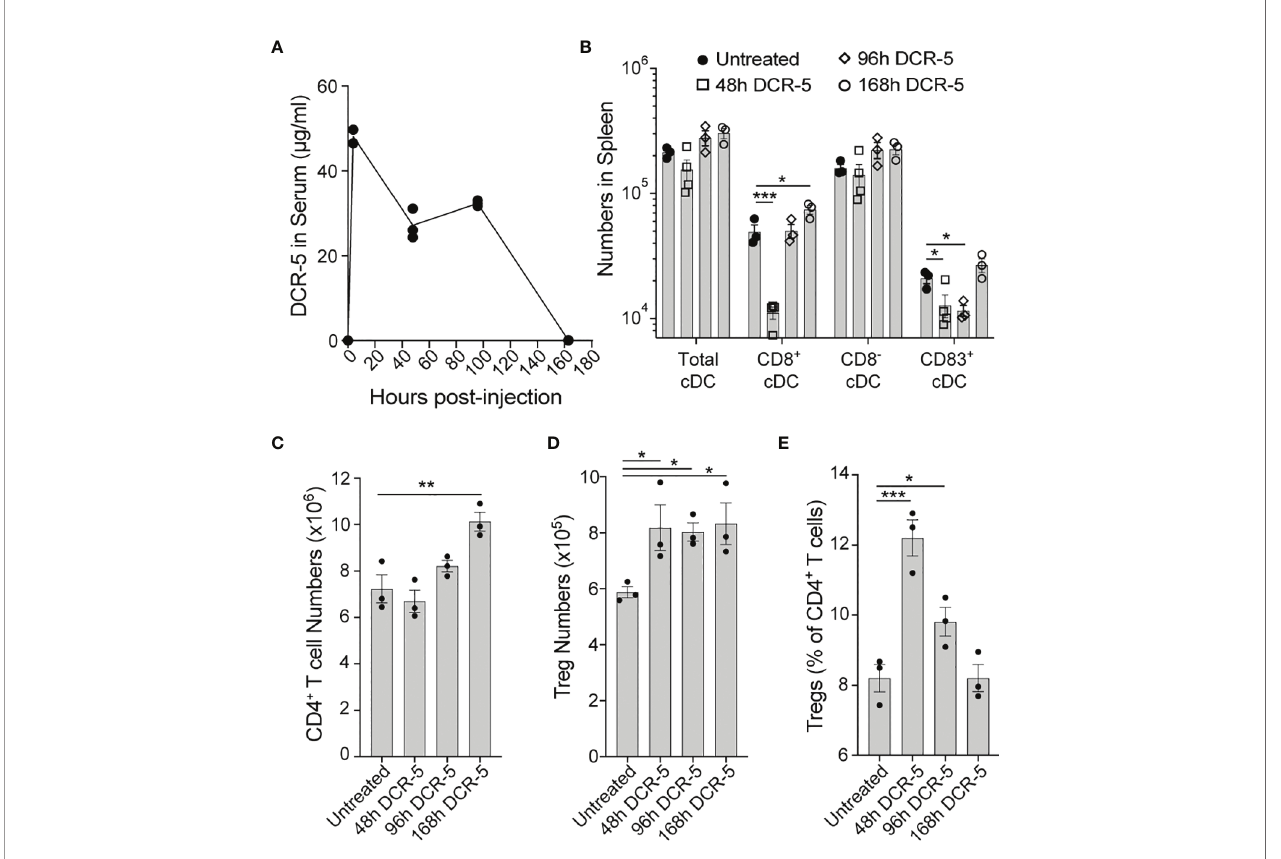
FIGURE 7 | Longevity of in vivo DCR-5 effects on DC and Treg. B6 mice were treated with a single i.p. injection of 150 µg of DCR-5 mAb. At the indicated timepoints post- injection, analysis of (A) DCR-5 concentration in serum by ELISA and total numbers of splenic (B) DC populations, (C) CD4 + T cells, (D) Treg and (E) Treg as a percentage of CD4 + T cells by fl ow cytometry was performed. Statistical comparison to untreated group was determined using one way ANOVA. *p < 0.05, **p < 0.01 and ***p <